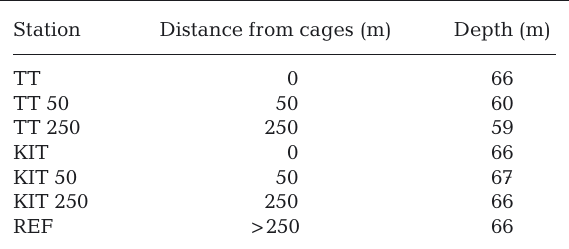
Table 1. Sampling stations at 2 tuna fattening farms (code- named TT and KIT) in Limassol Bay, Cyprus, distance from cages and bottom depth. REF: reference station, located 2